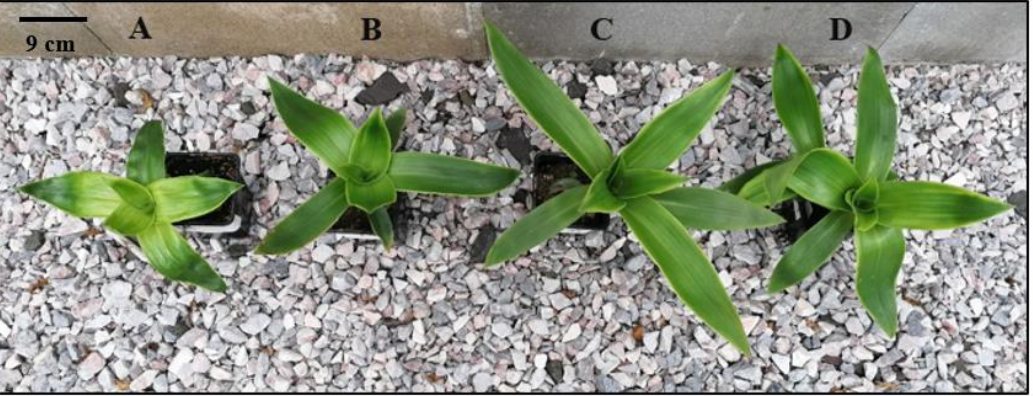
Figure 3. Two-week-old C. fragrans plants in ex vitro conditions: ( A ) control plant; ( B ) tetraploid genotype P2; ( C ) tetraploid genotype P3; ( D ) mixoploid genotype M1. All the induced genotypes produced shorter stolons compared to the control genotype.